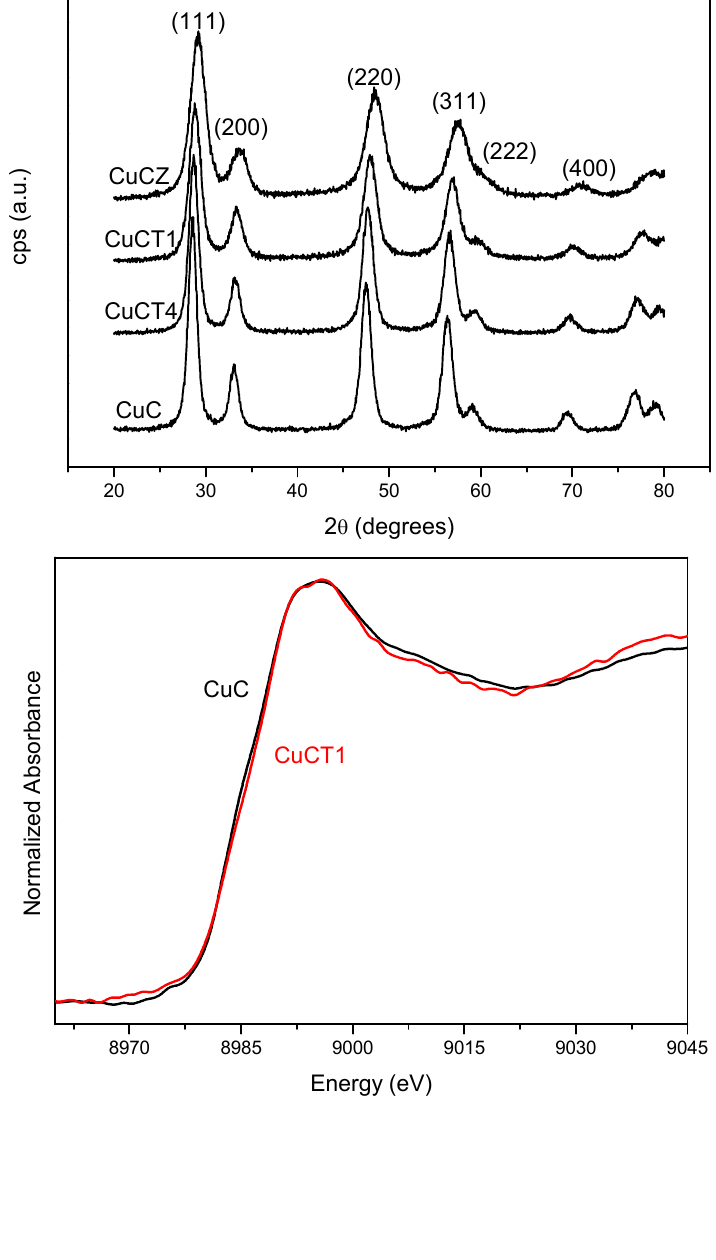
Figure 1. Top: X-ray diffractograms of catalysts with 1 wt.% copper oxide dispersed on ceria (CuC), Ce-Zr mixed oxide (CuCZ) and Ce-Tb mixed oxides with 4:1 (CuCT4) and 1:1 (CuCT1) Ce:Tb atomic ratios. Bottom: XANES spectra for the indicated